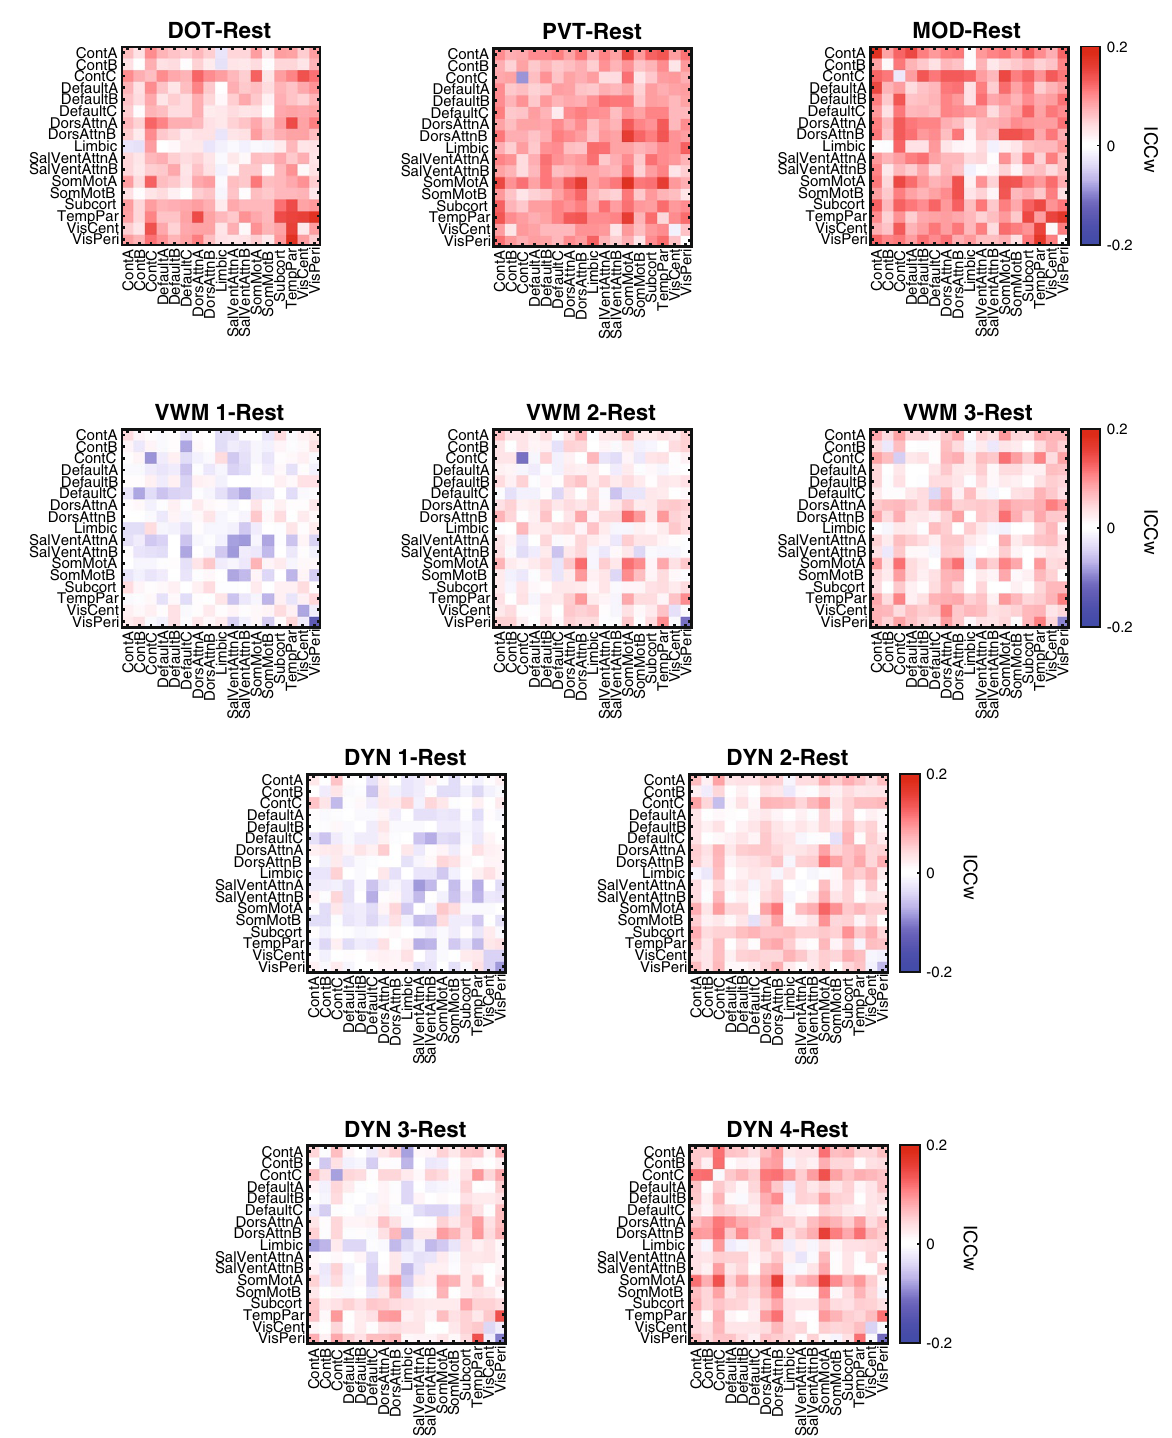
Figure 3. fMRI changes in reliability from resting-state for each task: DOT, PVT, MOD, VWM-1:3, and DYN- 1:4. Connections are mapped unto 17 cognitive systems from Schaefer cortical and Harvard–Oxford subcortical atlas. DOT dot probe task, DYN dynamic attention task, MOD modular math task, PVT psychomotor vigilance task, VWM 1–3 visual working